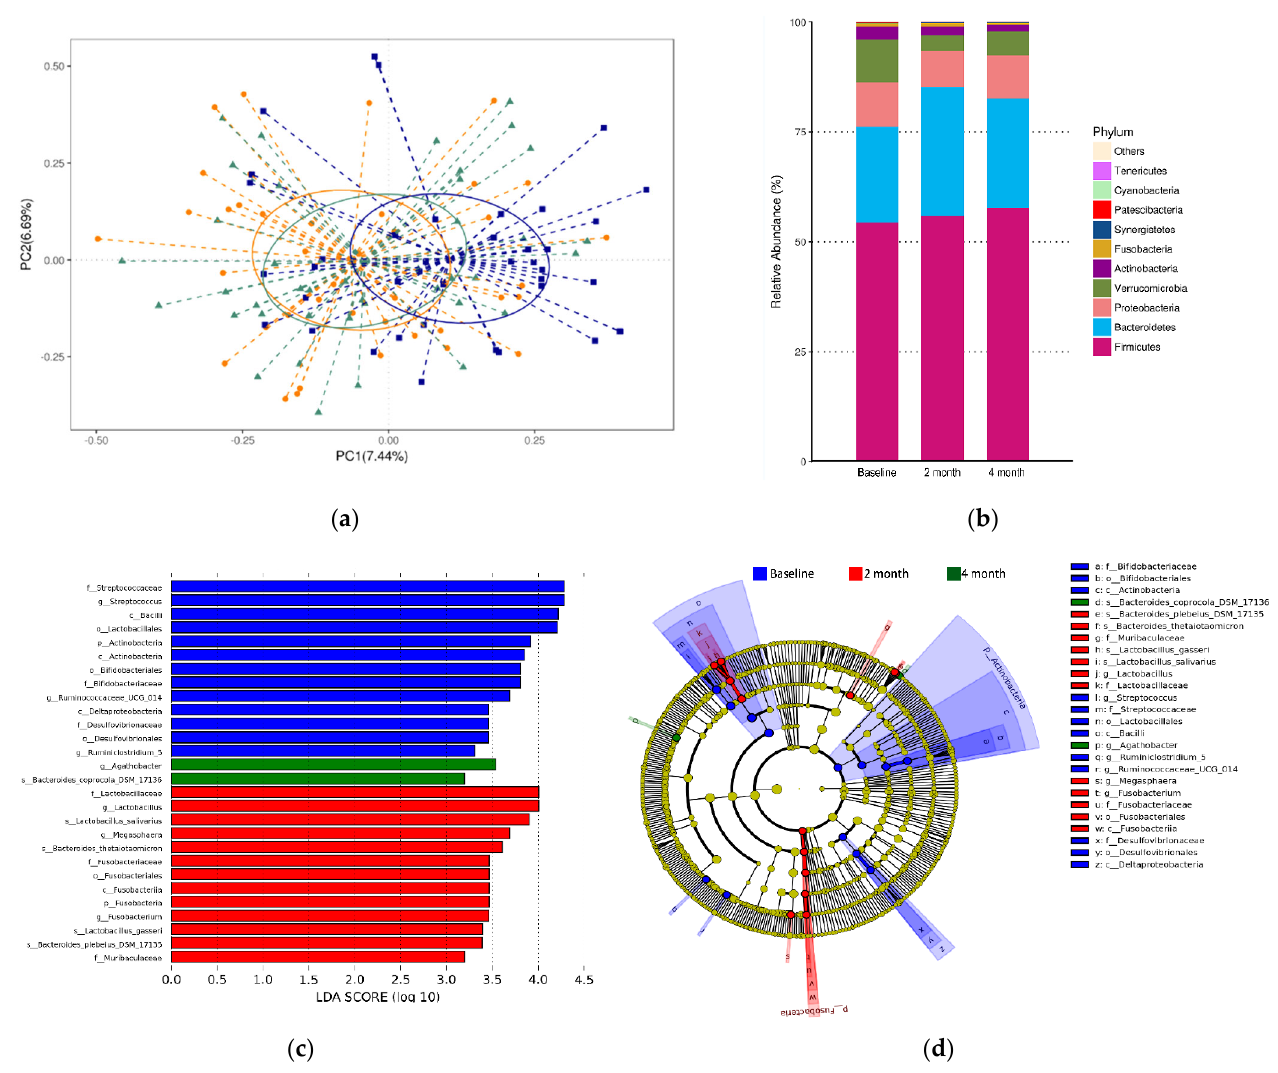
Figure 2. Fecal bacterial composition. ( a ) A score plot obtained from a principal coordinate analysis (PCoA) conducted to evaluate the effects of plant-based, antioxidant-rich smoothies and sesame seed snacks intervention on the composition of gut microbiota. The blue, orange and green spots represent the baseline, 2- and 4-month time points, respectively. Each spot represents a fecal sample. ( b ) The relative abundance of top 10 microorganism populations in feces at phylum level. ( c ) The varying taxa of gut microbiota identified using the linear discriminant analysis (LDA) effect size method. The length of the bar represents the log10 transformed LDA score. Only taxa with absolute LDA (log10) scores >3.0 were considered significant ( p < 0.05). ( d ) Cladograms predicting the phylogenetic distribution of bacterial lineages associated with the treatment duration. The rings extending from the inner to the outer layers represent different classification levels, namely phylum, class, order, family, genus, and species. The diameter of each circle is proportional to its relative abundance. The names of the taxon levels are abbreviated as follows: p = phylum; c = class; o = order; f = family, g = genus, and s =